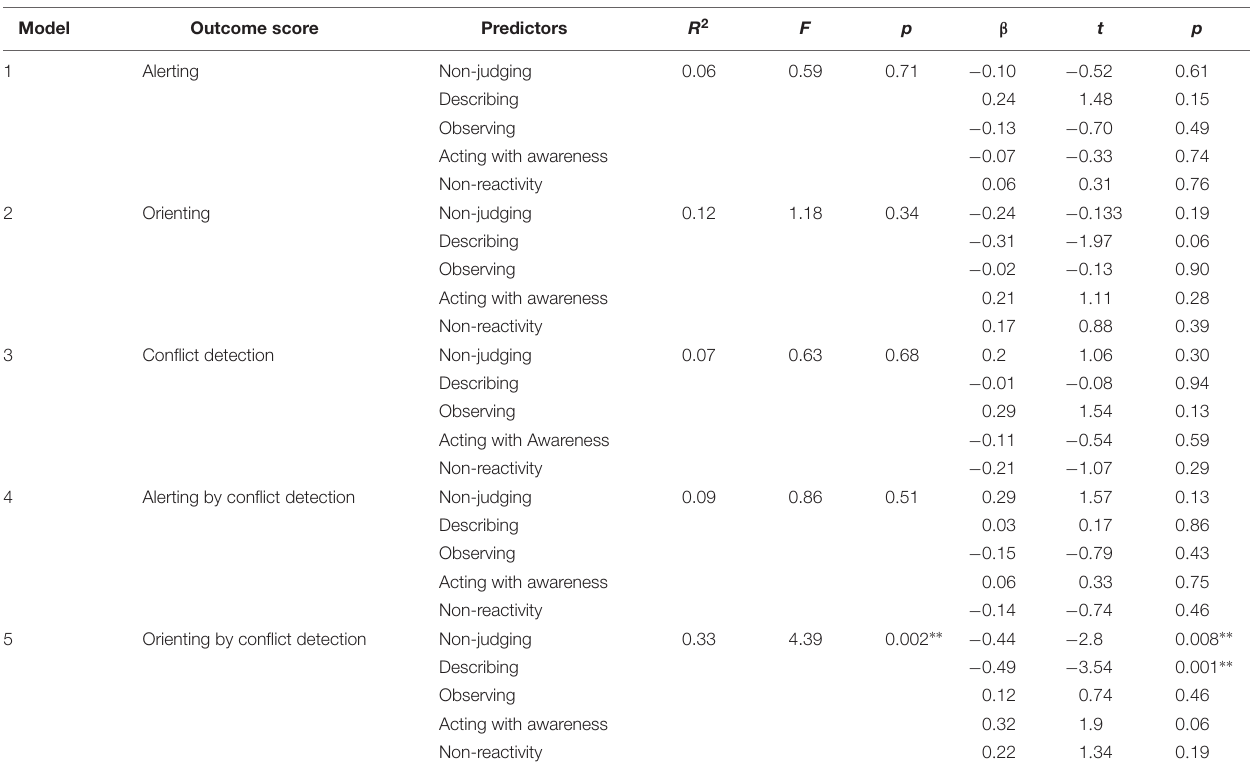
TABLE 3 | The prediction of the FFMQ facets on the ANT-R outcome scores.